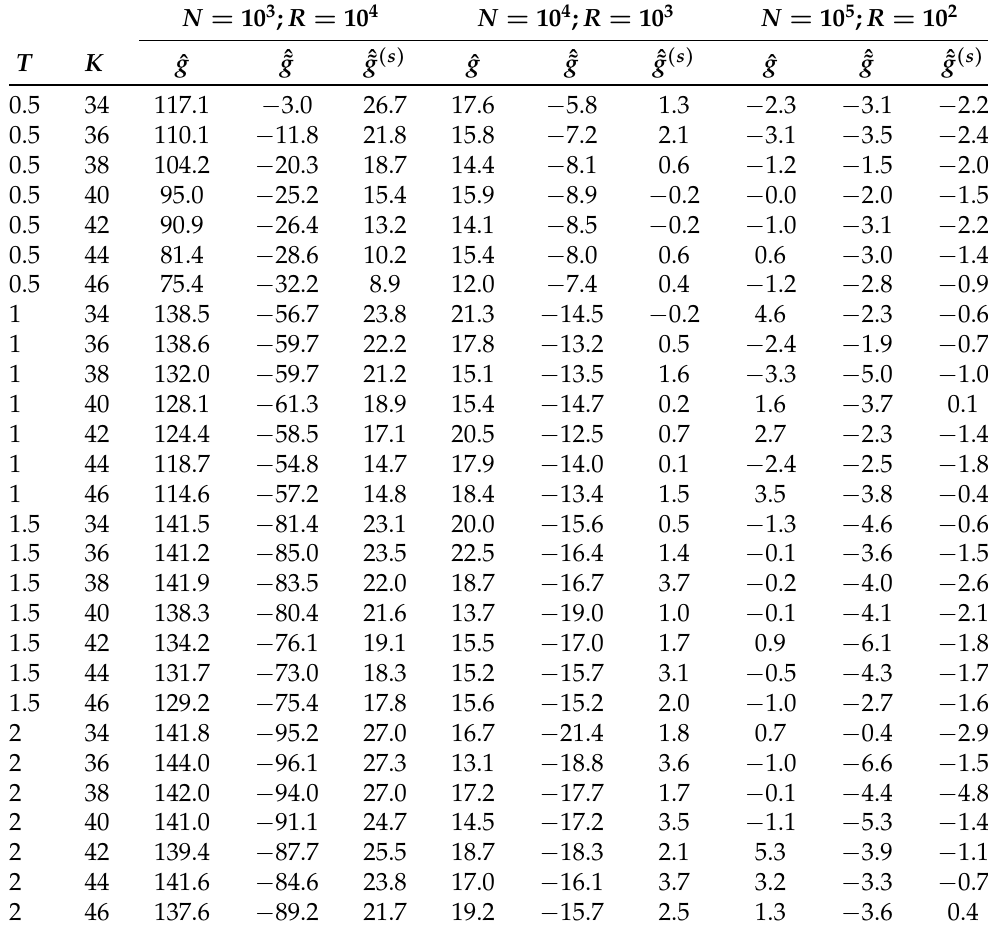
Table A2. Detailed bias results ( × 10 3 ) with GHS drift.